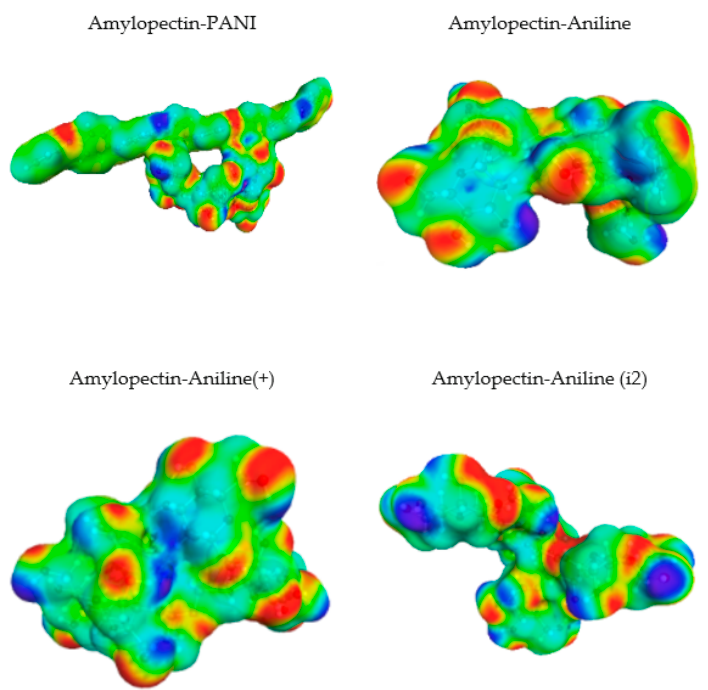
Figure 11. Molecular graph of the optimized PANI–amylopectin complex. Figure 11. Interactions in PANI/starch biocomposites using COSMO-RS.